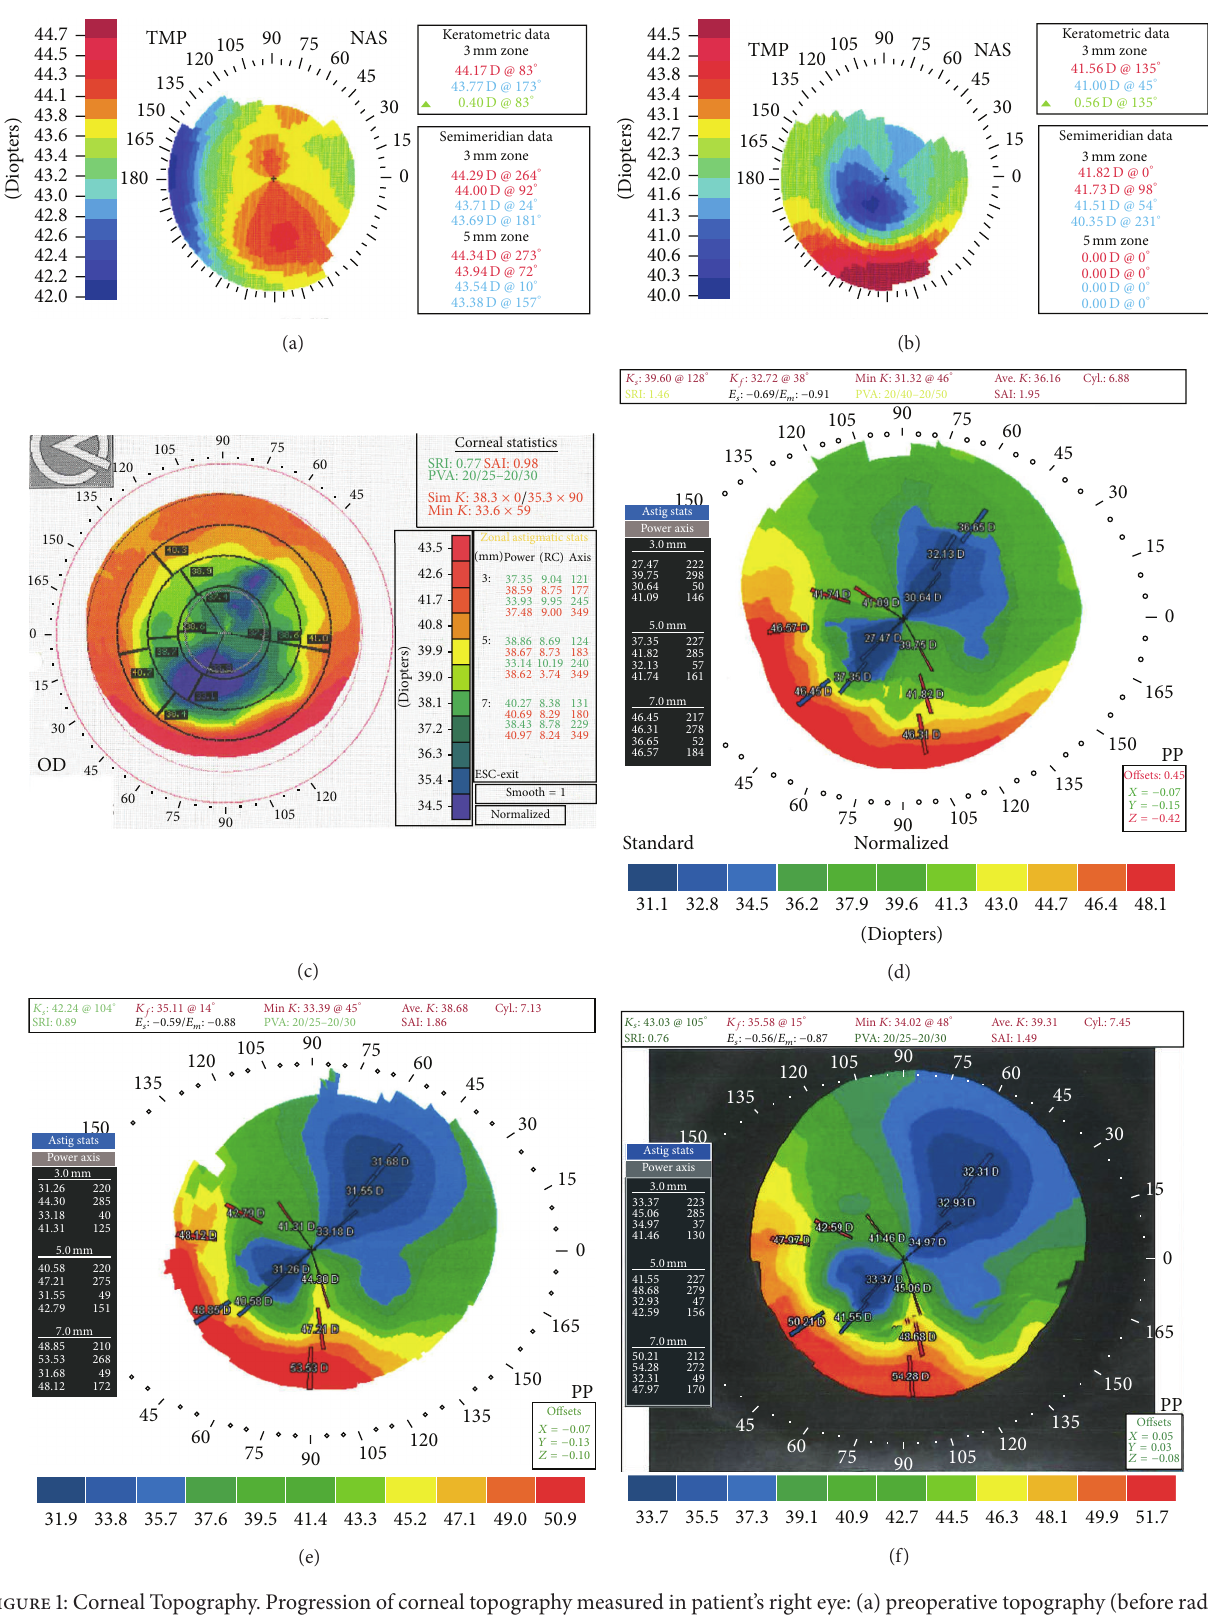
Figure 1: Corneal Topography. Progression of corneal topography measured in patient’s right eye: (a) preoperative topography (before radial keratotomy [RK]), (b) postoperative month 1 after RK, (c) postoperative month 5 after LASIK, (d) postoperative year 6 after LASIK, (e) postoperative month 4 after astigmatic keratotomy (AK), and (f) postoperative year 1.5 after